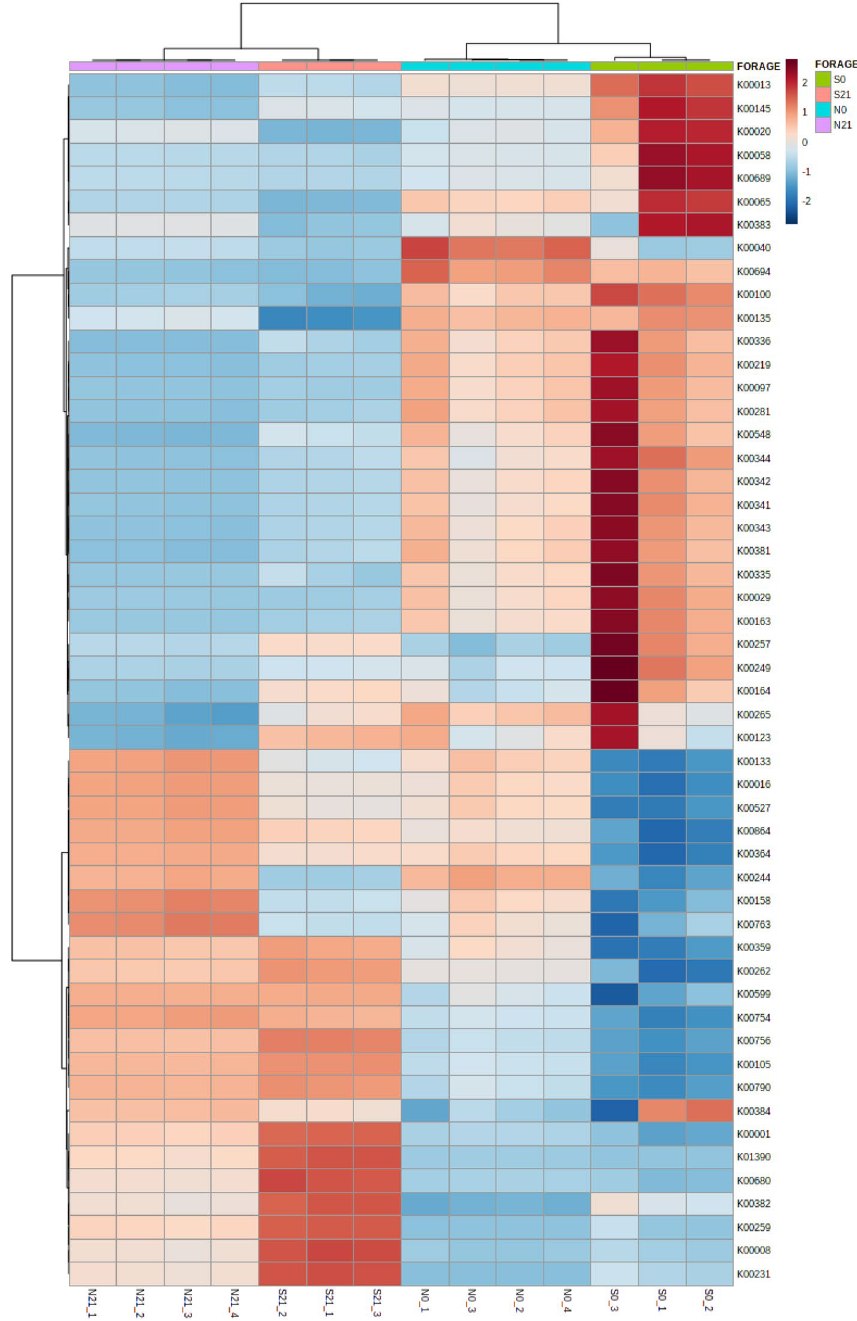
Figure 11. Heatmap constructed using differentially abundant KEGG functional profiles using Tax4Fun based on LEFSe analysis shown in Fig. 10. Pearson distance was used with the Ward clustering algorithm based on the current clustering algorithm. Red and blue indicate a higher and lower abundance,